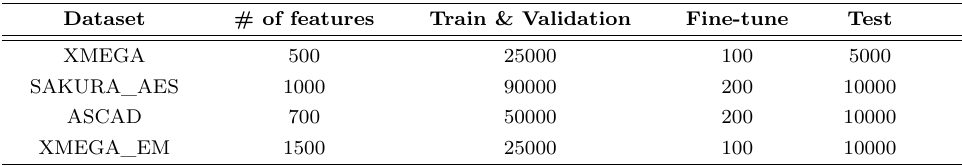
Table 1: Statistical information and the partition of all considered datasets.